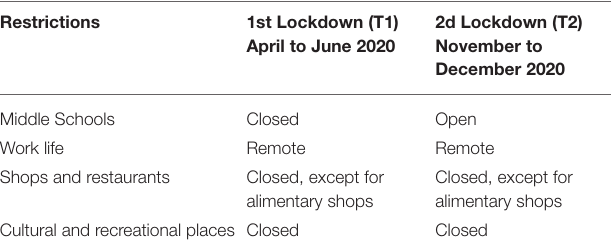
TABLE 1 | Lockdown conditions were comparable in T1 and T2, except that schools were closed during the first lockdown and open during the second